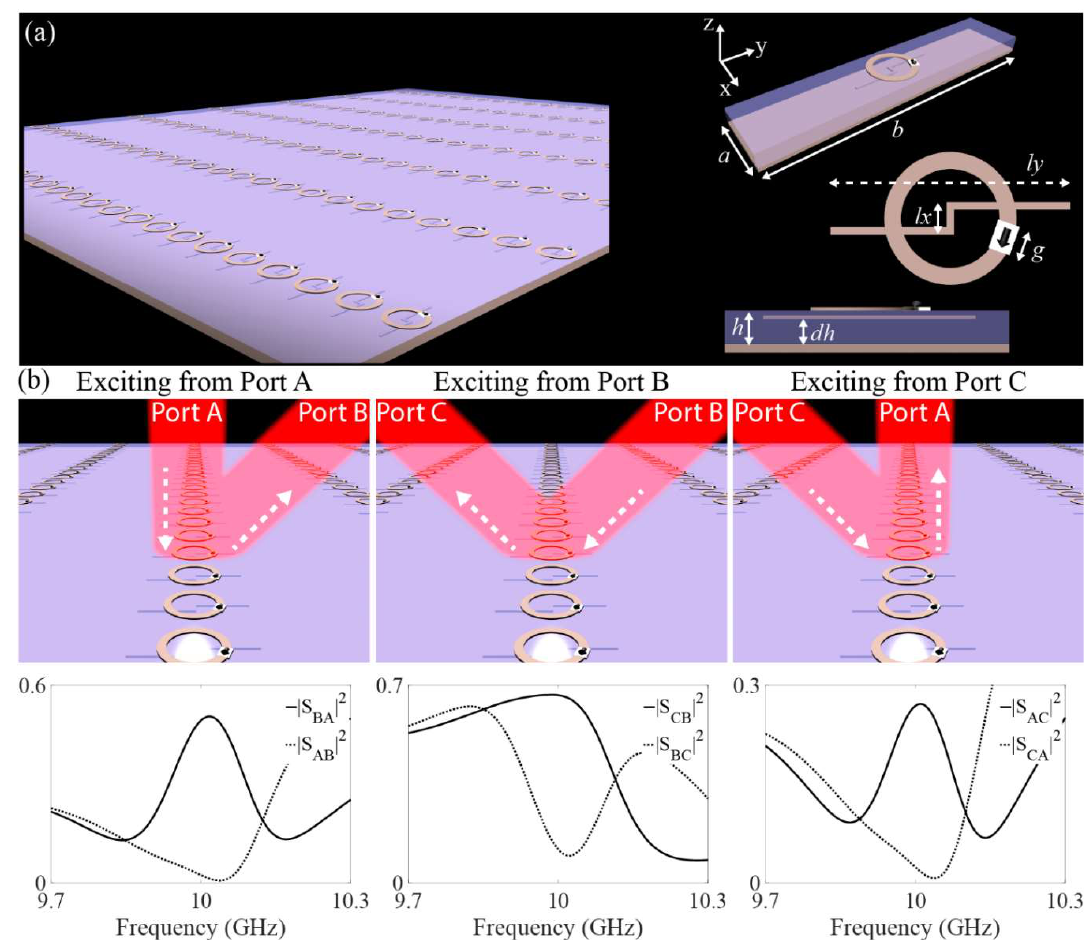
Figure 2. Array of bianisotropic moving particles designed to circulate space waves between three Floquet channels located with 45 degree angular distance. ( a ) Nonreciprocal metagrating. Inset shows a single inclusion composed of a loop loaded with an isolator to create one-way rotating magnetic dipole and a wire strip providing the required electric dipole response. ( b ) Results for isolation achieved between different Floquet channels. Geometric parameters of the design: outer radius of the loop is 3.53 mm, inner radius of the loop is 2.63 mm, g = 0.5 mm, b = 42.43 mm, a = 9 mm, h = 2.3 mm, dh = 2.15 mm, lx = 1.75 mm, ly = 12.2 mm, the width of the electric dipole is 0.4 mm, dielectric permittivity is 10.2, and loop is rotated for 15 degrees in the direction shown in the figure. The structure is simulated using infinite periodic boundary conditions. Here, for the sake of simplicity, we consider ideal lumped isolators.